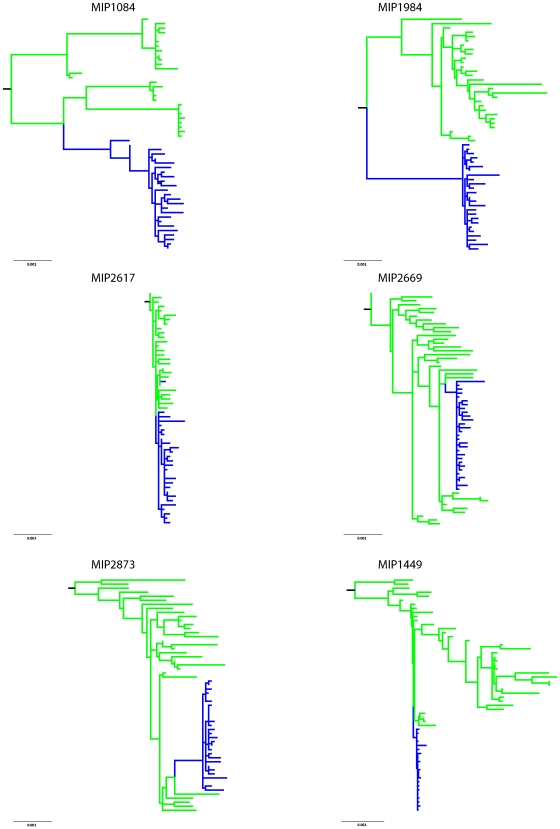
Rooted maximum-likelihood trees illustrating the epidemiologic linkage between sequences from mother (green) and infant (blue) subjects within each transmission pair.The nucleotide sequences of env V1-V5 region from each pair were aligned with two unrelated outgroup HIV-1 subtype C sequences obtained from the Los Alamos HIV Sequence Database. The branch containing unrelated outgroup sequences are not shown for space considerations. Only bootstrap support values greater than 75 are shown for the major nodes segregating mother and infant subjects.